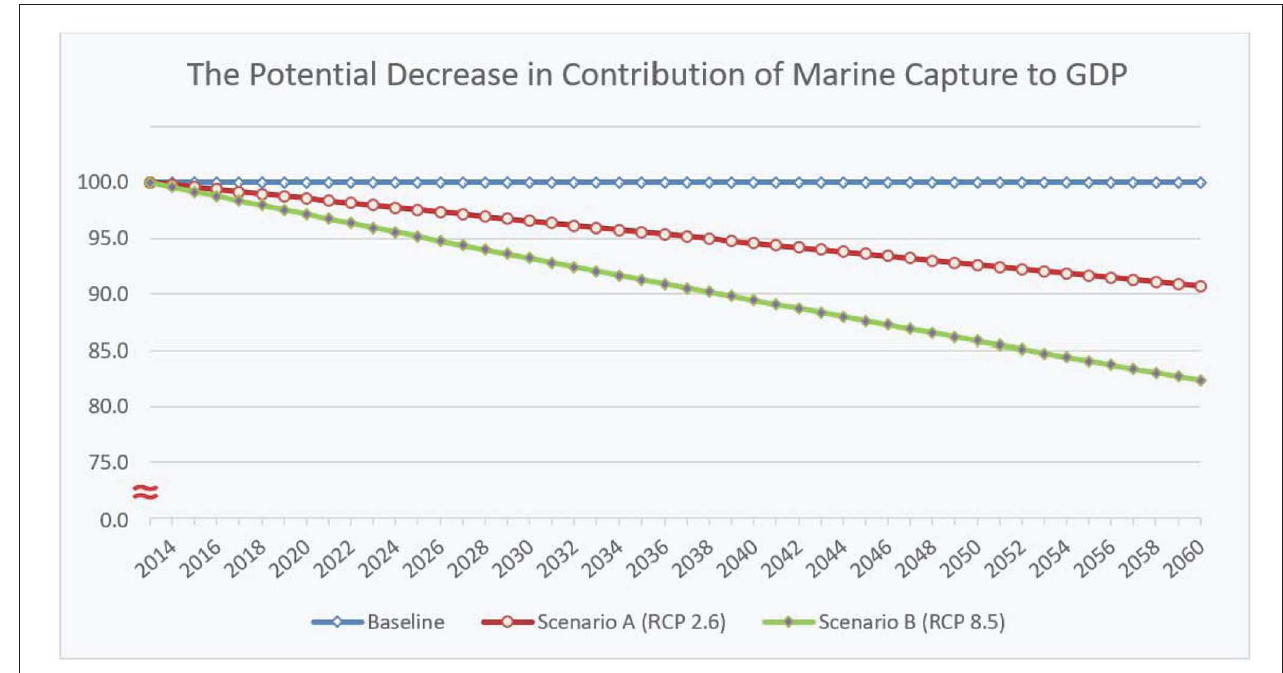
FIGURE 3 | Projection of decrease in contribution of marine capture to GDP by